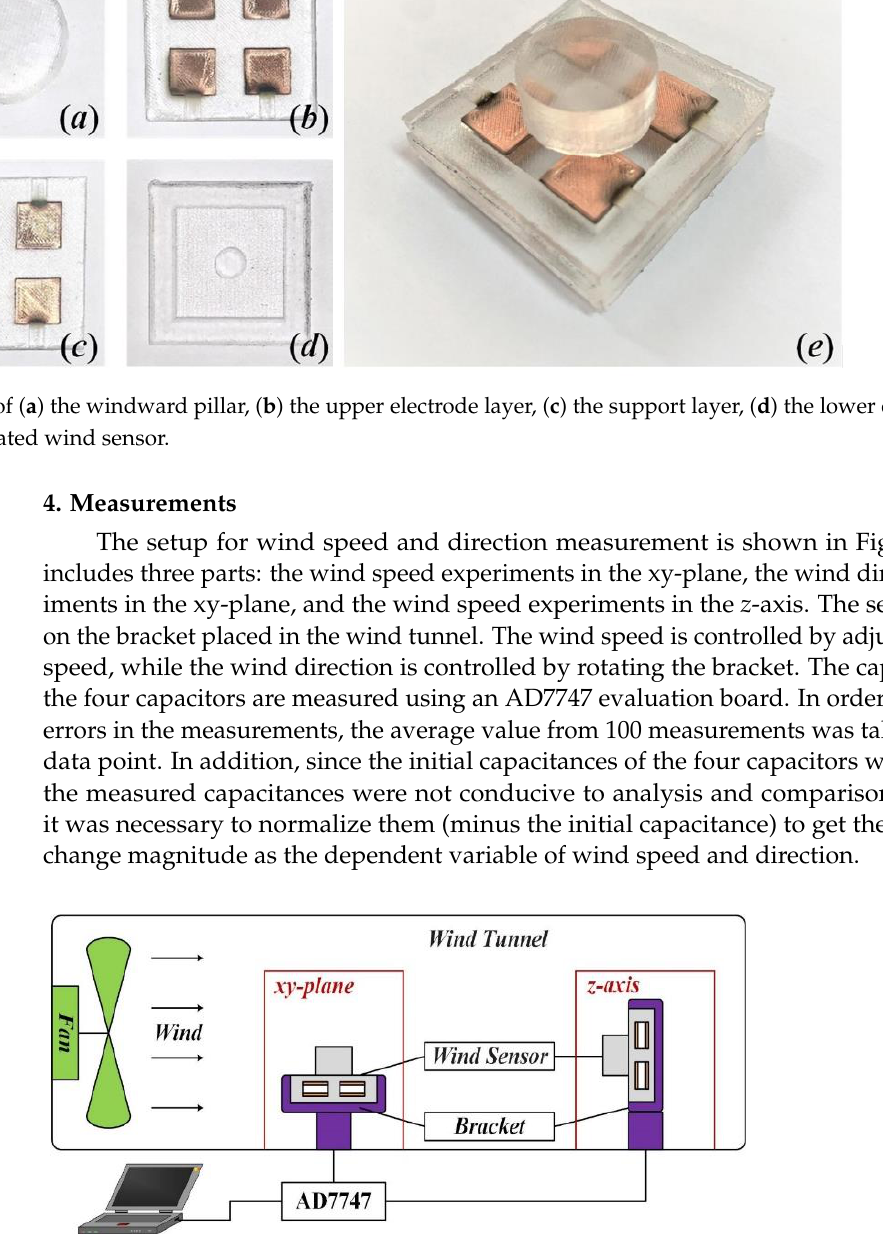
Figure 8. The setup for wind speed and direction measurement.